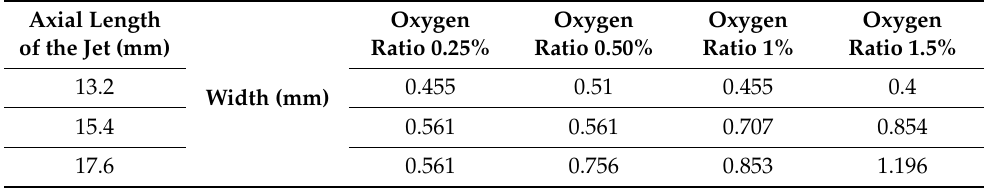
Table 4. Largest width of the jet for oxygen/argon admixture discharge and the equivalent length. Axial Length of the Jet